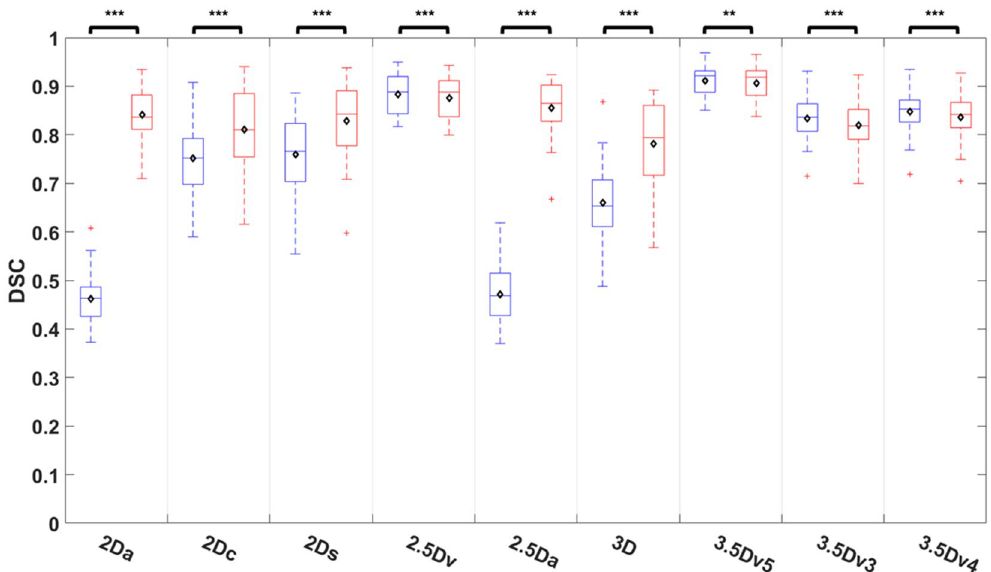
Figure 4. Comparison of DSC among 9 U-Nets before and after E&D.